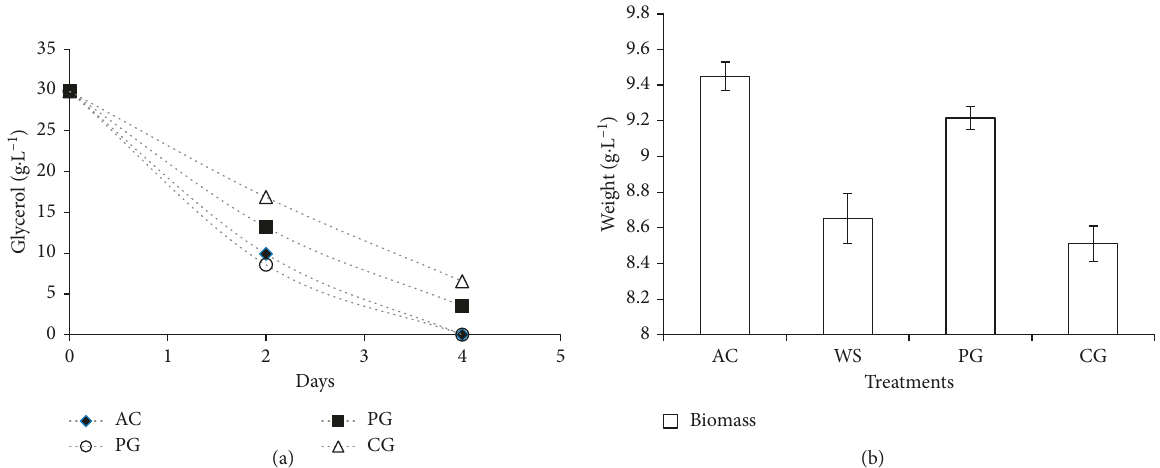
Figure 3: The glycerol consumption and biomass growth by A. terreus under the treatment of AC and WS. (a) Glycerol consumption. (b) Biomass production taken on day 6. In (a), the glycerol consumption in AC improved considerably, similar to positive control. In (b), the biomass production was not affected by the pretreatments.